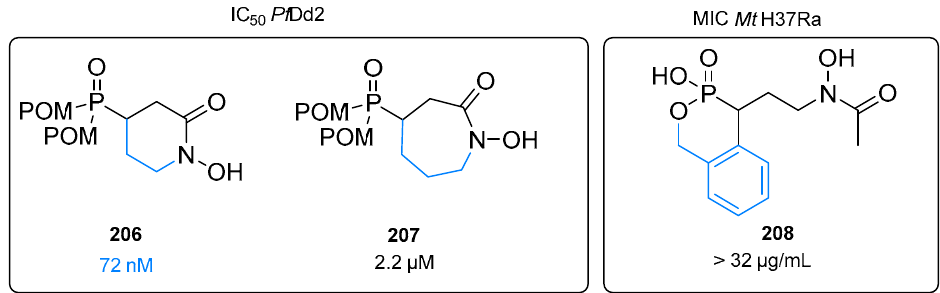
Figure 38. Inhibitory activity of rigidized prodrugs 206 – 208 against Pf Dd2 or Mt H37Ra.